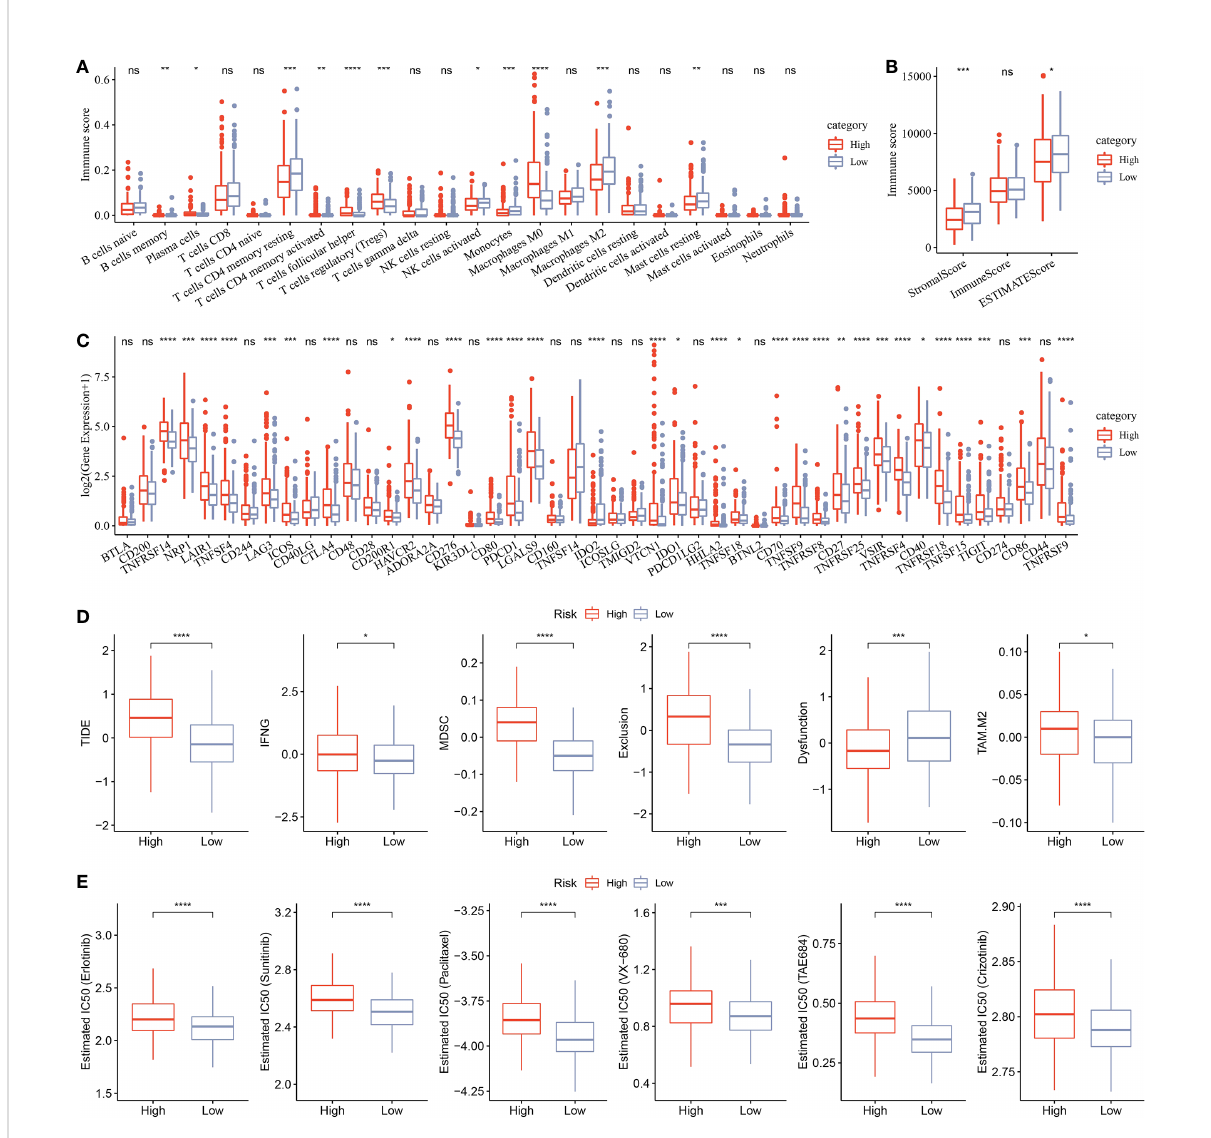
FIGURE 11 Analysis of immune in fi ltration. (A) Analysis of 22 immune cells using CIBERSORT. (B) Analysis of immune in fi ltration using ESTIMATE. (C) The expression levels of 42 immune check genes between low group and high group. (D) The differences of TIDE, IFNG, MDSC, Exclusion, Dysfunction, and TAM.M2 between low group and high group. (E) IC50 of traditional drugs in the low group and high group. *p<0.05, **p<0.01, ***p<0.001, ****p<0.0001, ns, no signi fi